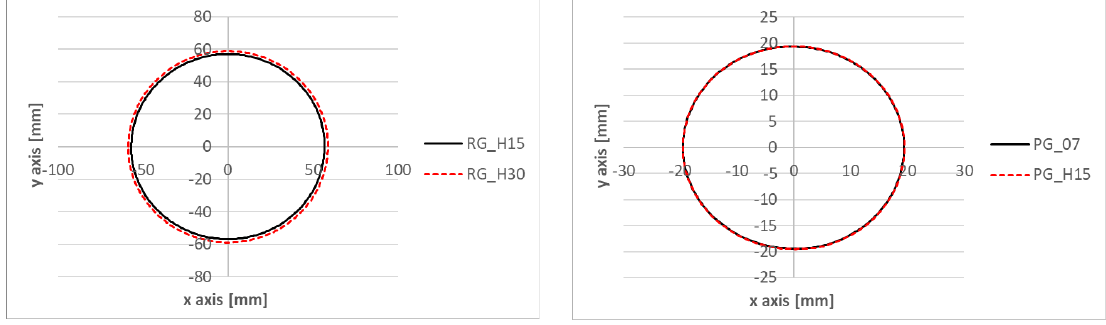
Figure 8. Main results of punch CP analysis.